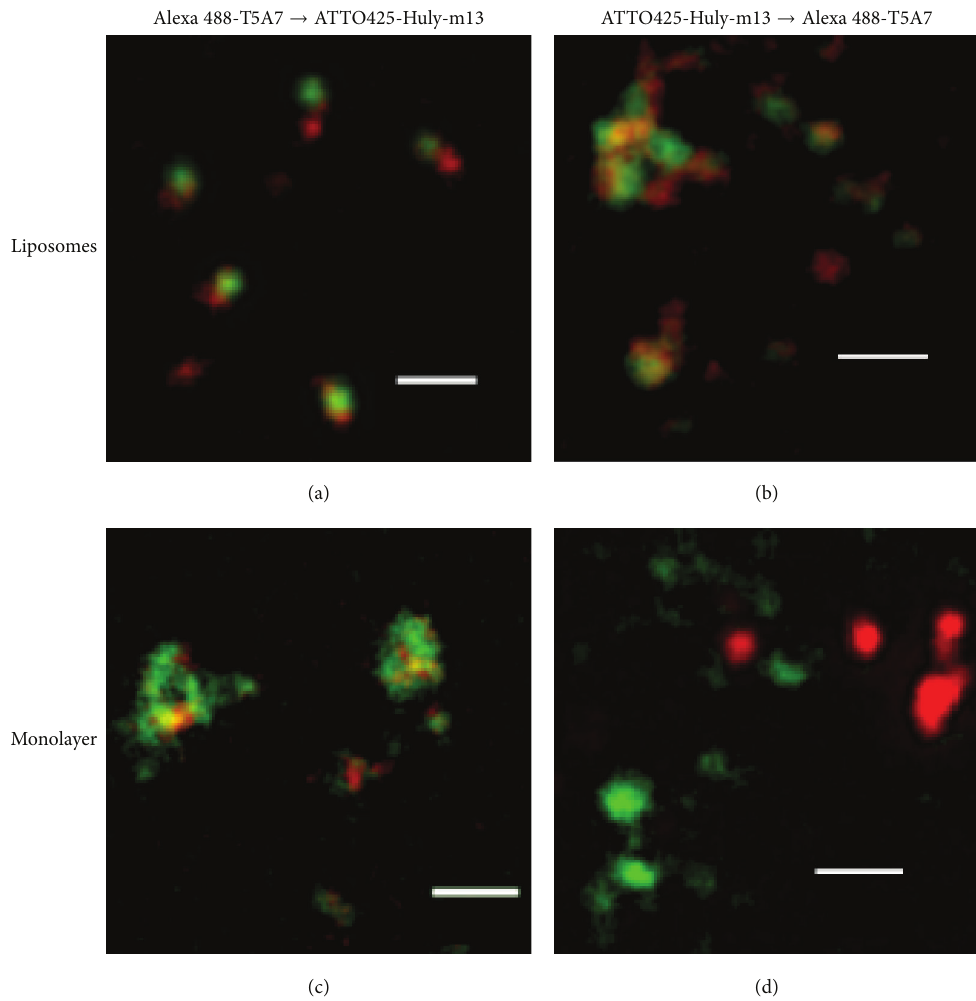
Figure 1: Stimulated emission depletion (STED) microscopic observation. The LacCer/DOPC liposomes (a, b) and LacCer and DOPC in ethanol (c, d) were coated onto the back surfaces of 96-well NUNC Immunoplates, followed by overnight incubation at room temperature with gentle shaking. The chemical condition of the backside surface of the plate was the same as the surfaces of the wells. The coated plates were blocked with BSA, sequentially stained with Alexa 488-T5A7 (green) ATTO425-Huly-m13 (red) (a, c) or ATTO425-conjugated Huly- m13 (red) → Alexa 488-conjugated T5A7 (green) (b, d), and viewed under a TCS STED CW superresolution microscope (Leica), with signals detected using a GaAsP hybrid detection system (Leica). Deconvolution was performed using Huygens STED deconvolution software (Leica). The panels on the right show enlargements of those on the left. White bars depict 1 𝜇